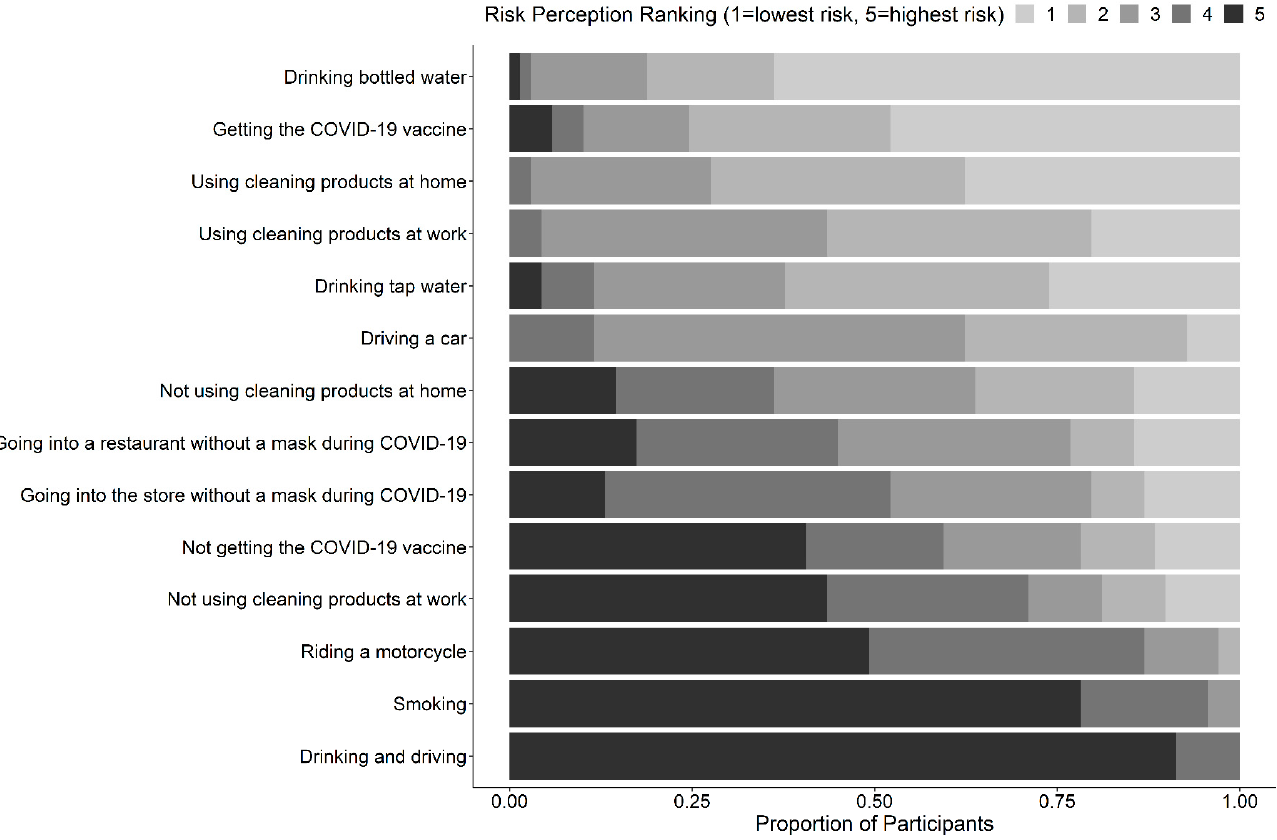
Figure 1. Risk perception ranking of general, COVID-19-related, and cleaning and disinfection (C&D) related activities, ordered from smallest to largest mean score from top to bottom on the y axis.